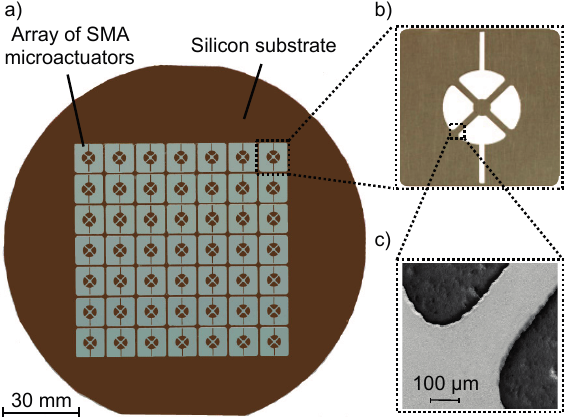
Figure 3. ( a ) Array of SMA film microstructures on a silicon substrate covered by a sacrificial layer; ( b ) Magnified photograph of a single SMA microactuator; ( c ) Scanning electron microscope (SEM) picture of a single SMA beam. Reprinted with permission from [33], copyright 2014 IOP Science.